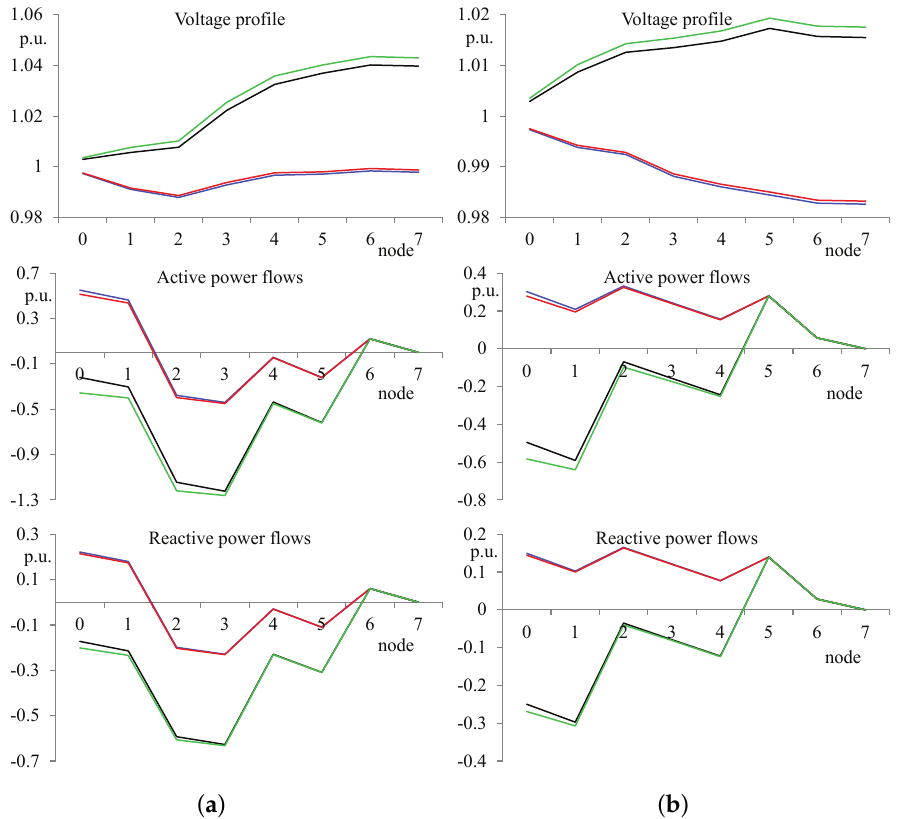
Figure 6. Voltage amplitudes and power flows along feeder 1 ( a ) and feeder 2 ( b ) evaluated by the proposed model and by load flow solution: Case A—proposed model (red) and load-flow (blue); Case B—proposed model (green) and load-flow (black). Table 2. Maximum relative